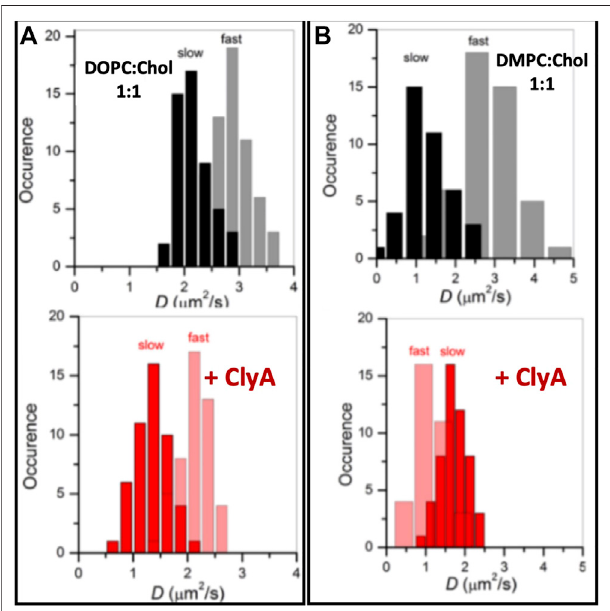
FIGURE 10 | Lipid dynamics on supported lipid bilayers of two compositions DOPC:Chol (1:1) (A) and DMPC:Chol (1:1) (B) in the absence (top) and presence (bottom) labelled with Atto488DMPE. Upon ClyA interaction, the domains with fast and slow dynamics reorganised to result in slowed down lipid diffusion. Adapted from Sarangi and Basu